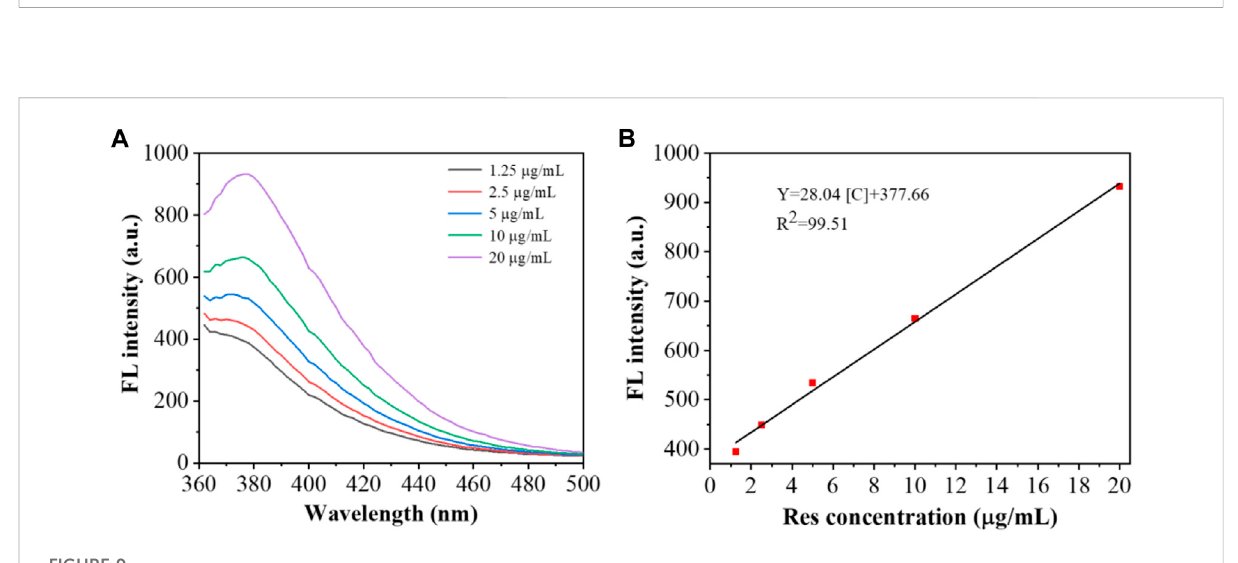
Fluorescence spectra (A) and corresponding linear calibration plot for Res (B)